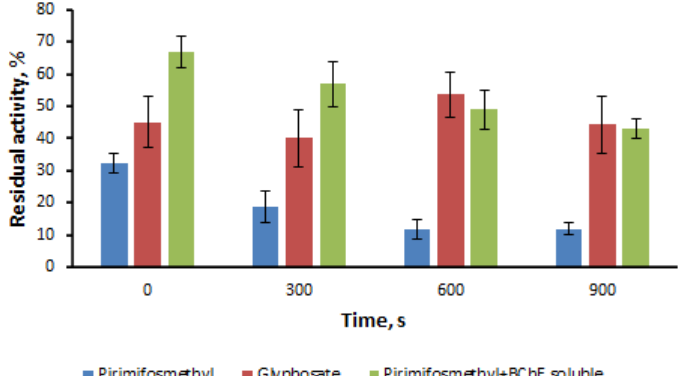
Figure 6. Residual activity of immobilized enzyme preparations based on starch gel vs. the time of incubation in the inhibitor solution ((pirimiphos-methyl) = 0.055 mM, (glyphosate) = 10 mM). Each preparation disk contained 0.11 U of BChE and 0.2 mM DTNB. Green columns are the residual activity of soluble BChE after incubation in 0.055 mM pirimiphos-methyl solution.